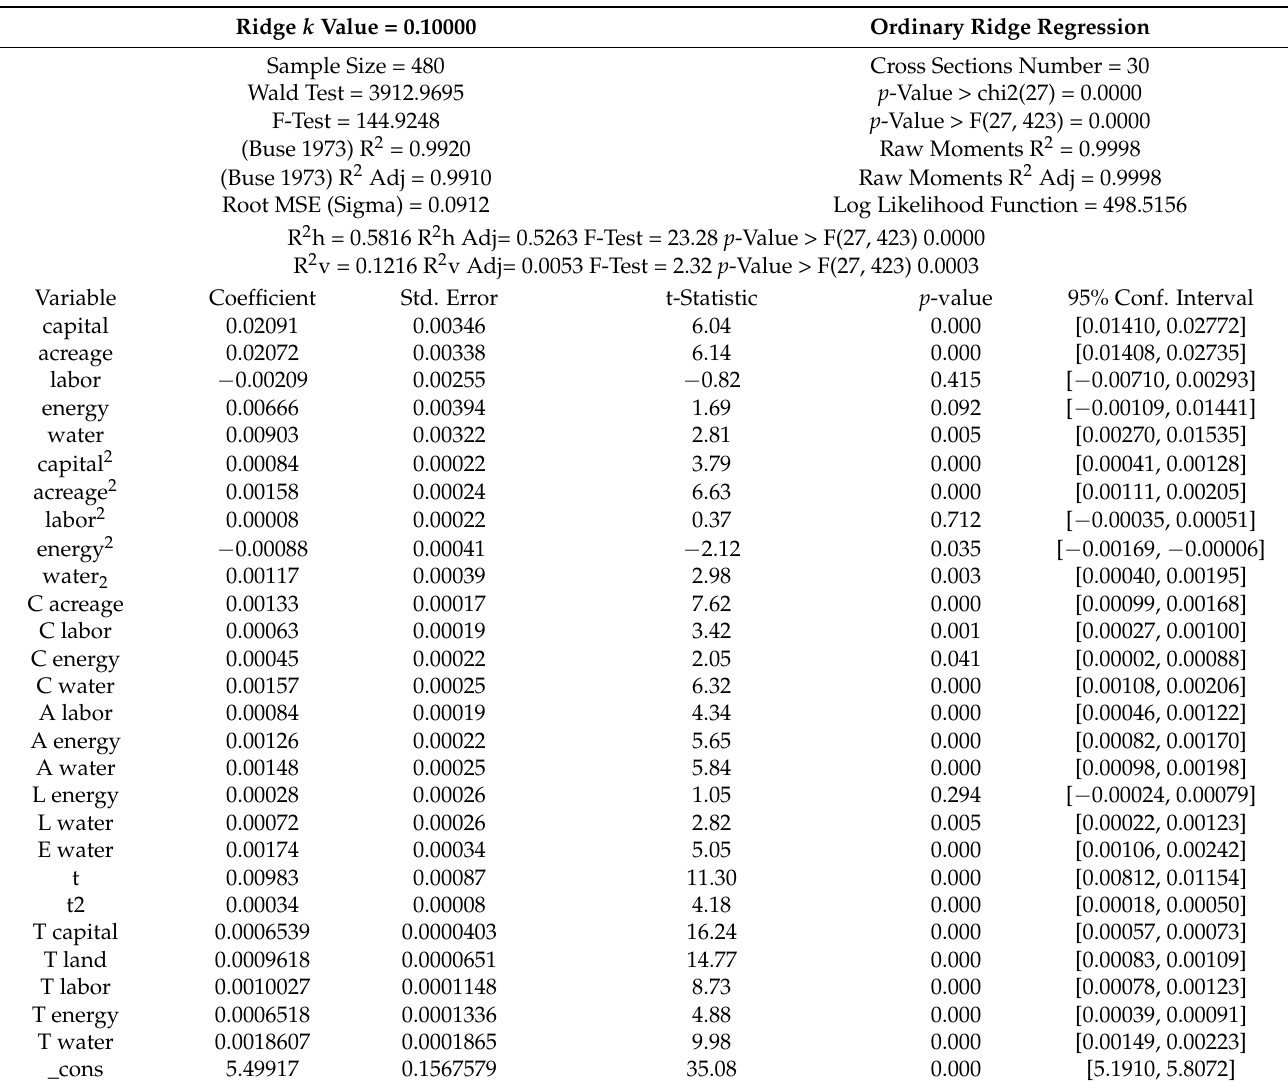
Table 4. Parameter estimates of the translog production